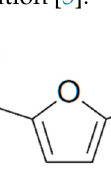
Figure 1. 5-Hydroxymethylfurfural (HMF) structure.